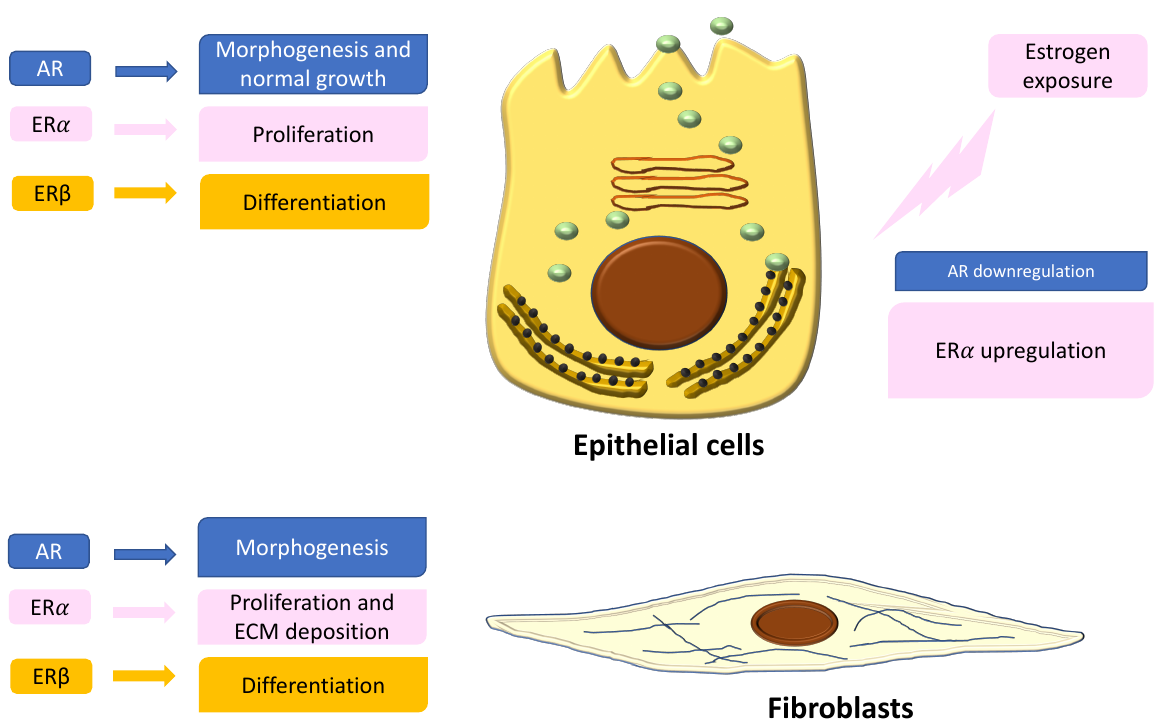
Figure 1. Localization and expression of steroid receptors in epithelial cells and fibroblasts. On the left is shown the role of the receptors in the regulation of cell functions. On the right is shown the different expression of androgen receptors (ARs) and estrogen receptors (ERs) after estrogen exposure during critical windows of